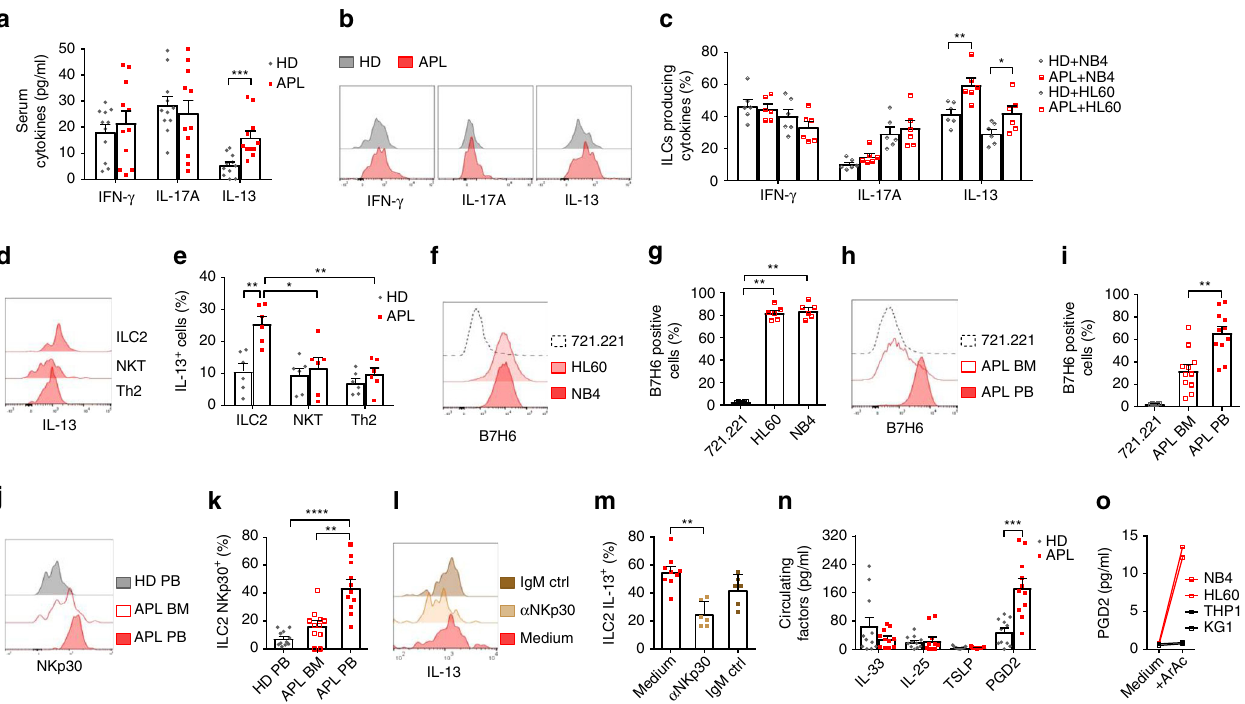
Fig. 2 NKp30-B7H6 interaction and tumour-derived PGD2 favour IL-13 secretion. a Cytokine concentrations in serum samples of HD and APL patients (APL) ( n = 11). b Representative examples of fl ow cytometry analysis of cytokine production by ILC in HD and APL patients (APL). c Frequencies of cytokine producing ILC in HD and APL patients (APL), upon co-culture with APL cell lines for 48 h (six independent experiments). d Representative example of fl ow cytometry analysis of IL-13-positive cells upon co-culture with autologous APL blasts. e Frequencies of IL-13 + ILC2, NKT and Th2 cells ( n = 6). f Expression of B7H6 and g frequency of B7H6-positive cells in APL cell lines (NB4, HL60) and a control cell line (721.221, lymhphoblastoid cell line) (six independent experiments). h Representative example of fl ow cytometry analysis of the expression of B7H6 and i frequency of B7H6-positive